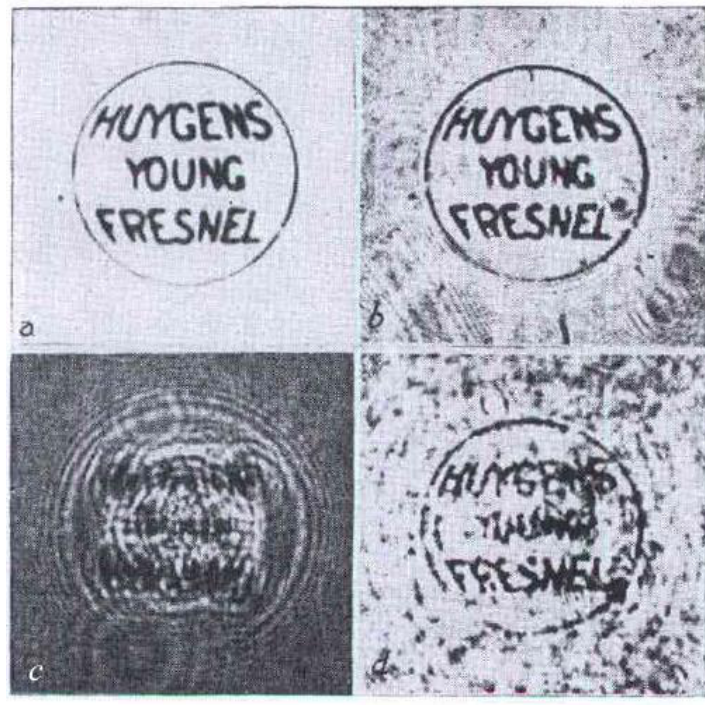
Figure 4. Gabor’s optical hologram [12].